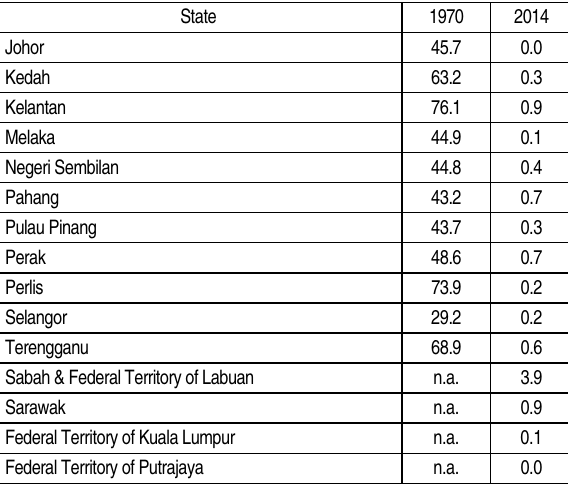
Table 1. Incidence of poverty by state in percentage, Malaysia, 1970 and 2014